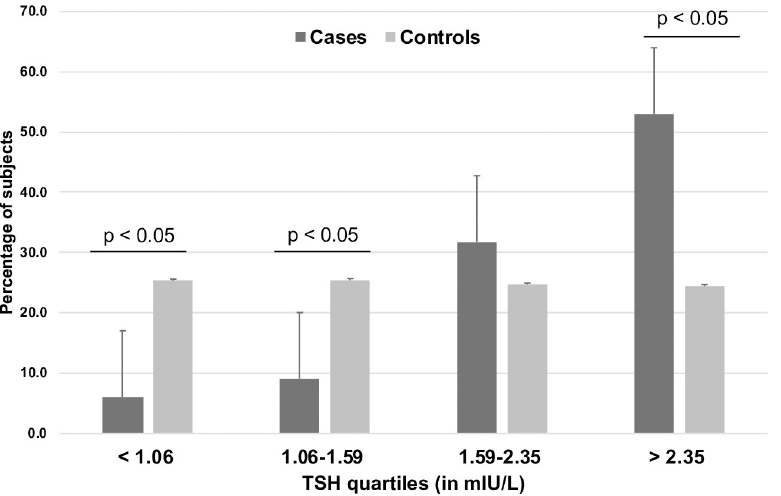
Fig 1. Percentage of cases and controls in each TSH quartile. There were lower number of cases compared to controls in the 1 st and 2 nd quartiles (p < 0.05) and higher number of cases compared to controls in the 4 th quartile of TSH level (p <